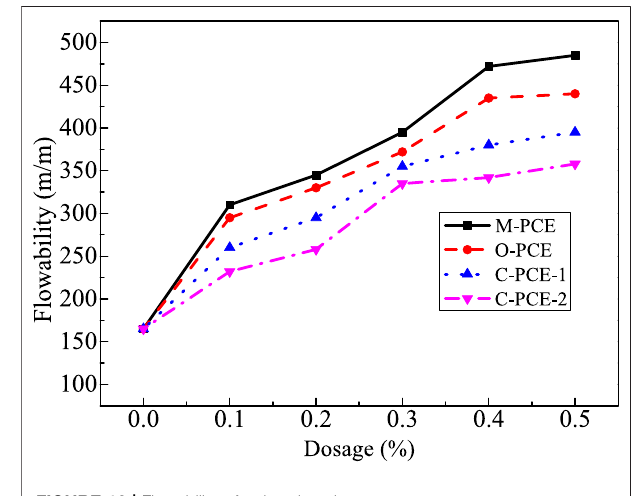
FIGURE 14 | The surface tension of polycarboxylates at different mass fractions.